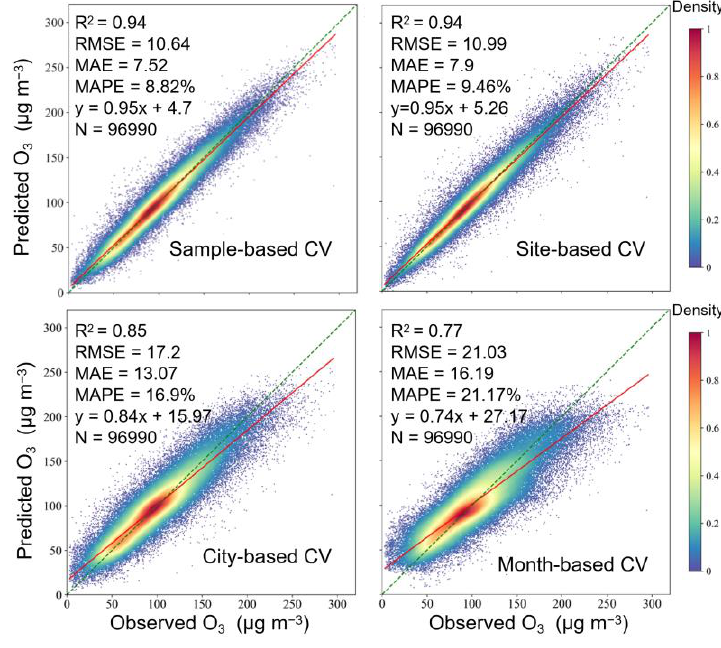
Figure 6. CV results.